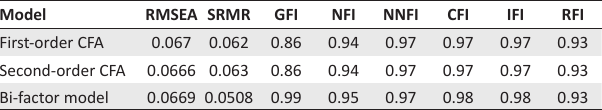
TABLE 3: Goodness-of-fit indices obtained for the Authentic Leadership Inventory first-order and single-factor measurement models. Model